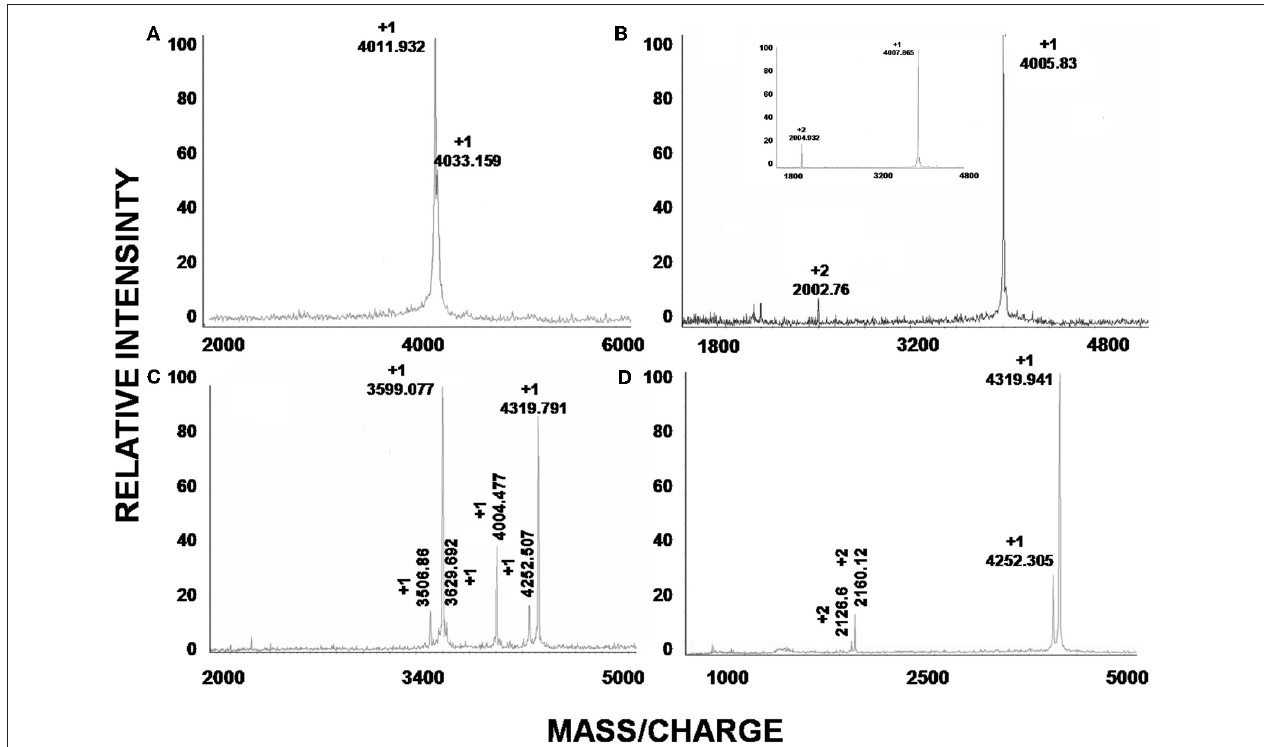
FIGURE 3 | Mass spectroscopic analysis of peptides. (A–D) are the mass spectra of the peaks obtained by HPLC with retention times 11.2, 40.0, 40.6, and 42.0min, respectively. (B) Correspond to the observed mass of native Juruin (4005.83) and reduced Juruin (inset).